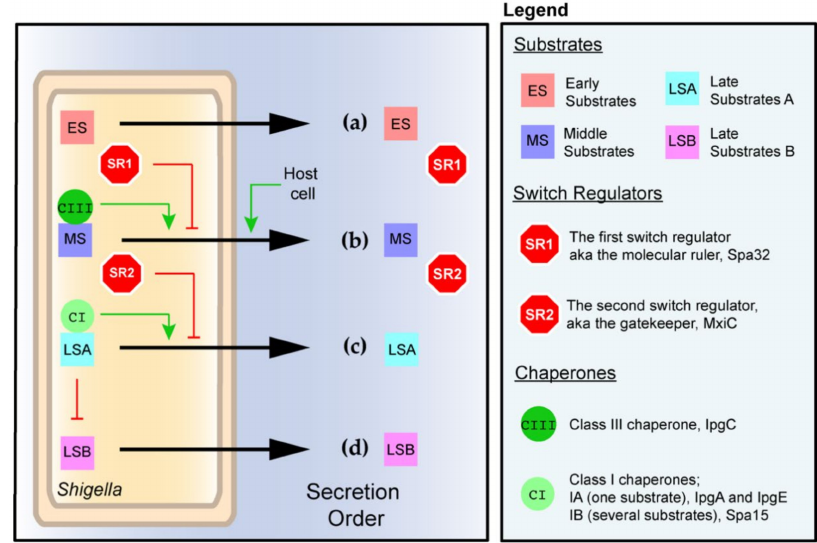
Figure 2. The ordered secretion of the T3SA in Shigella and its main regulators. ( a ) The early substrates are secreted as soon as expressed to assemble the inner rod and needle. The concomitant secretion of the first switch regulator Spa32 allows secretion of small amounts of middle substrates IpaD and IpaB to yield the inactive T3SA represented in Figure 1a. ( b ) The contact with host cells activates the T3SA, allowing the secretion of middle substrates and the second switch regulator MxiC. This, in turn, triggers the successive secretion of late substrates A ( c ) and late substrates B ( d ). The black arrow represents the secretion by the T3SA. The control of the production of late substrates B by late substrates A is described in Figure